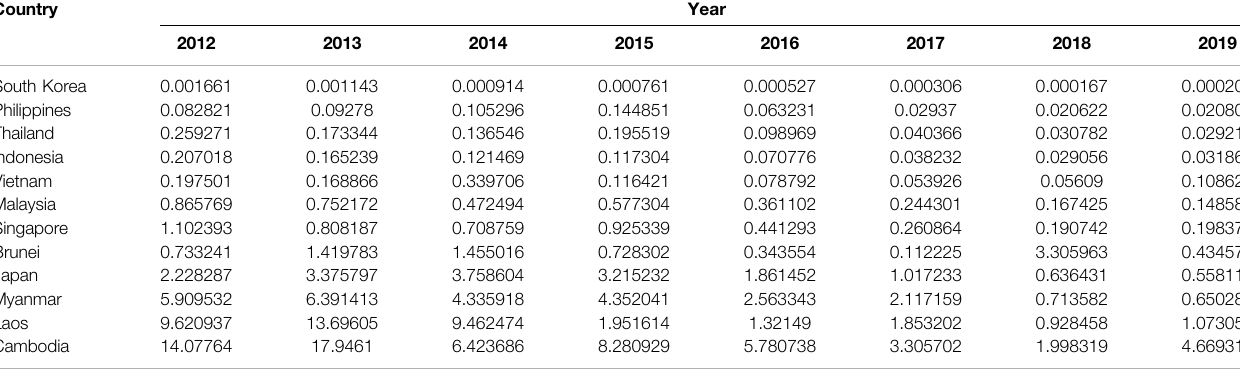
TABLE 8 | Time trend of the export ef fi ciency values of China ’ s solar PV exports to ASEAN plus Japan and South Korea.